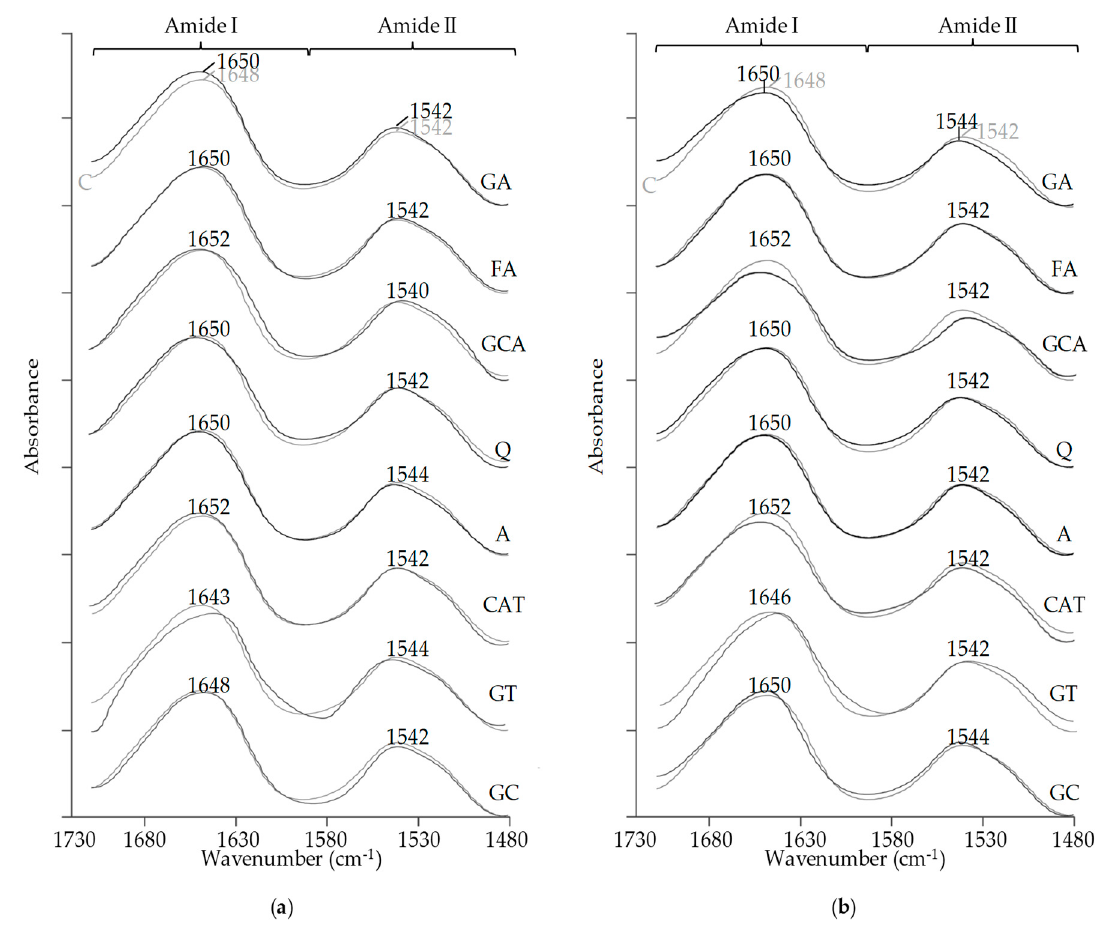
Figure 9. The effect of phenolic compounds on the FT-IR spectra absorbance at regions associated with amides I and II: ( a ) albumins; and ( b ) globulins. C–control sample (grey line), GA, FA, CGA, Q, A, CAT, GT, GC–protein samples after incubation with gallic acid, ferulic acid, chlorogenic acid, quercetin, apigenin, catechin, green tea, and green coffee extract, respectively.